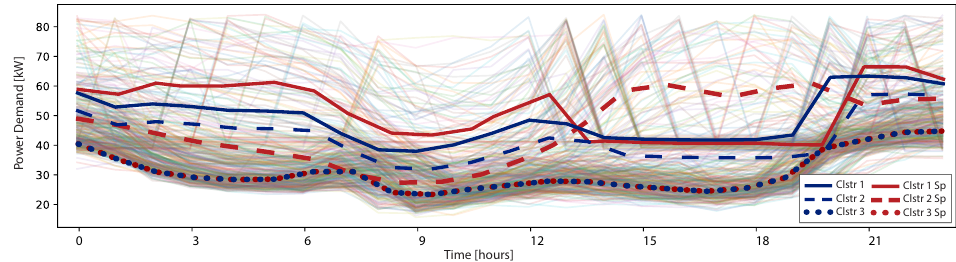
Figure 10. Clustering with/without Coincidence